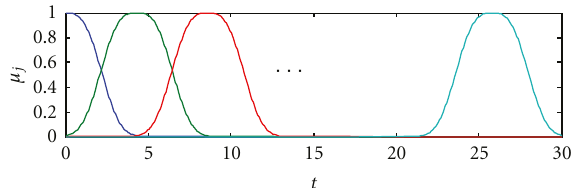
Figure 3: Fuzzy log-polar histograms representing the spatio- temporal shape contextual information of action